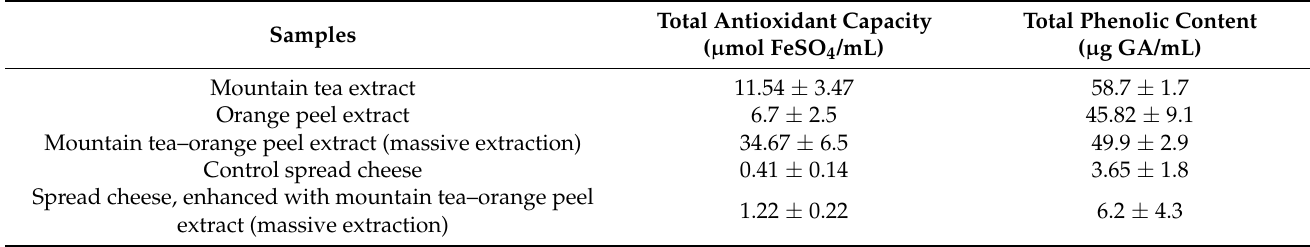
Table 2. Total antioxidant capacity and total phenolic content obtained in vitro for sample extracts and spread cheeses.